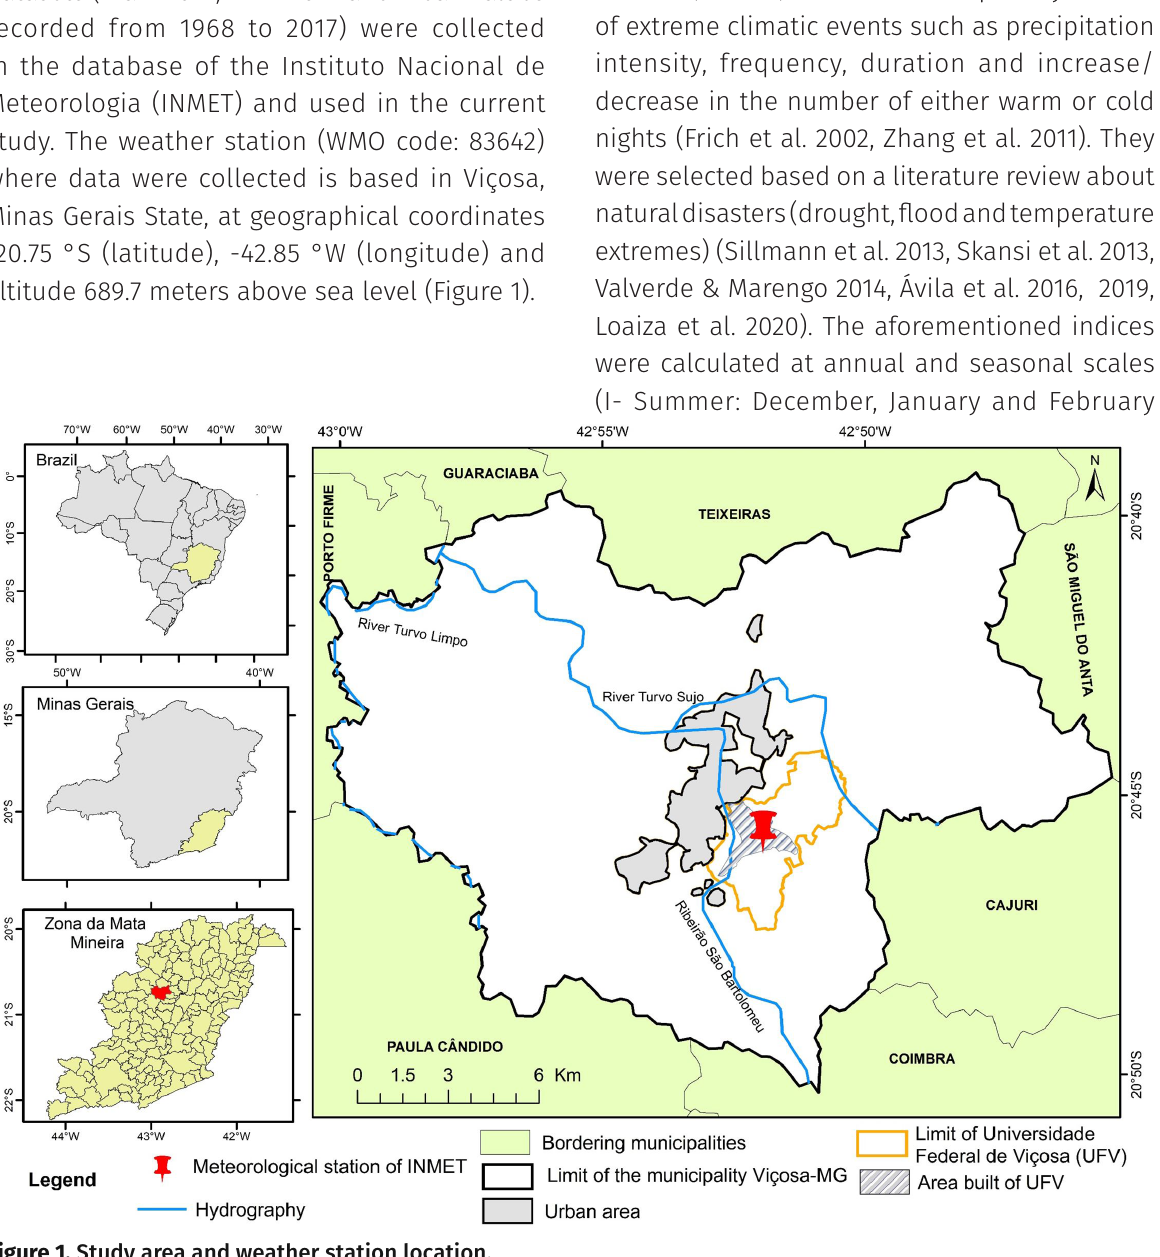
Figure 1. Study area and weather station